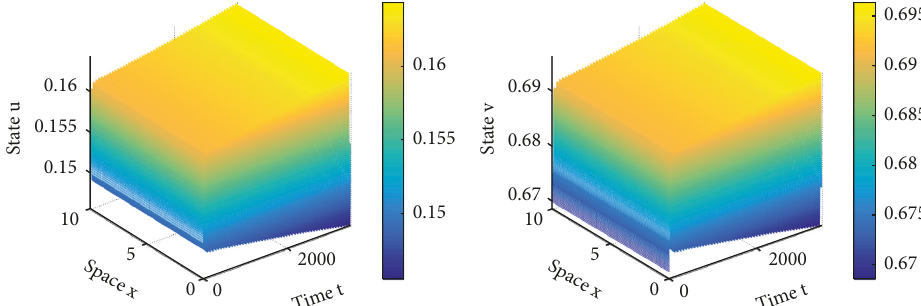
� 0 . 1 ,D � 0 . 1 and τ � 26 . 2 > τ 0 1 2